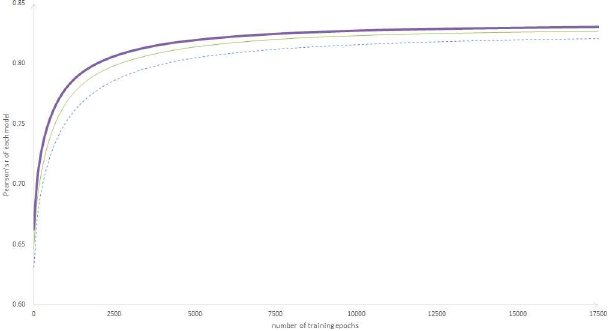
Fig 4. Pearson’s r of different weight factors over training steps. The horizontal axis represents the number of training epochs, and the vertical axis represents the Pearson’s r value. The dotted line indicates the MaLSTM, the thick solid line indicates the D-LSTM with α = 0.2, and the fine solid line indicates the D-LSTM with α =